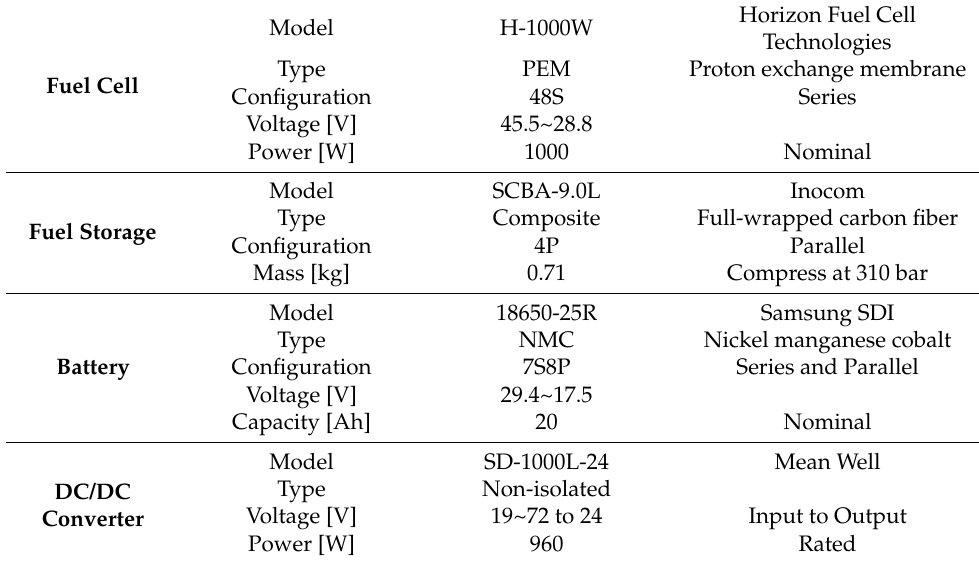
Table 1. Procured component